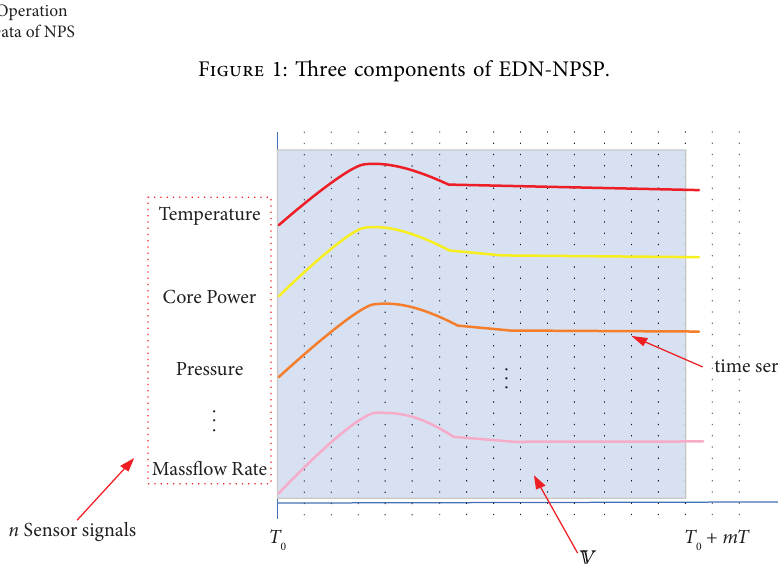
Figure 2: Data series and observation window of NPS with the size of n × m